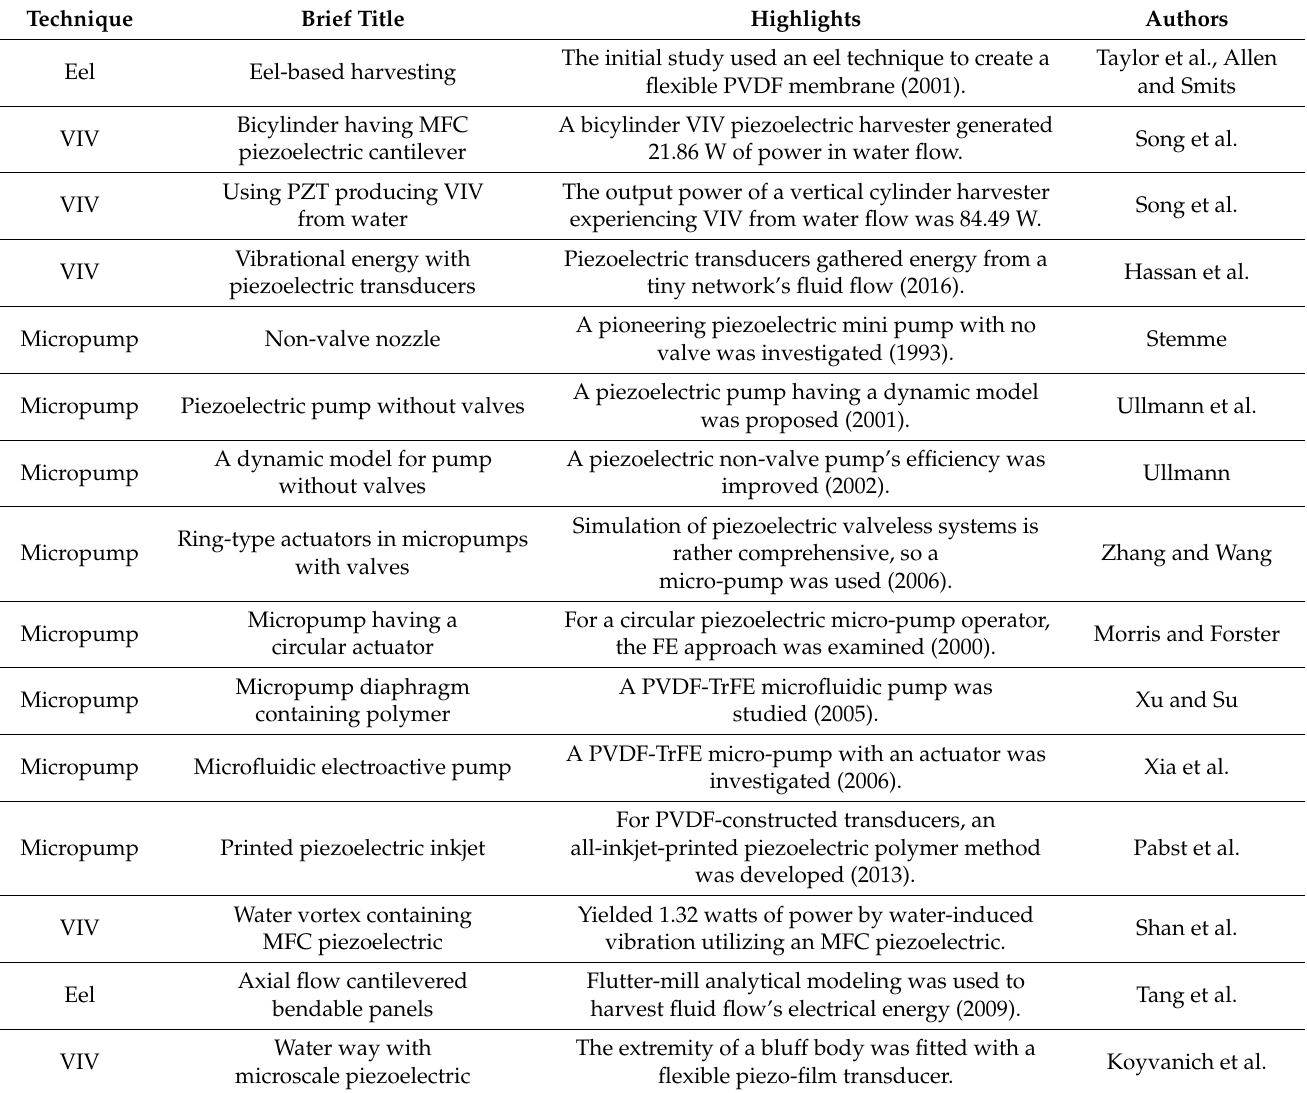
Table 4. Piezoelectric materials in water